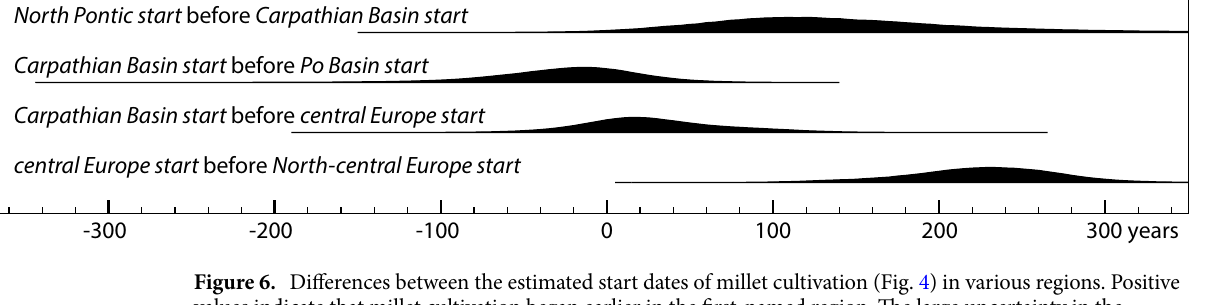
Figure 6. Differences between the estimated start dates of millet cultivation (Fig. 4) in various regions. Positive values indicate that millet cultivation began earlier in the first-named region. The large uncertainty in the North Pontic start date (due to low data density in this region) is responsible for the uncertainty in the time lag between the North Pontic and the Carpathian